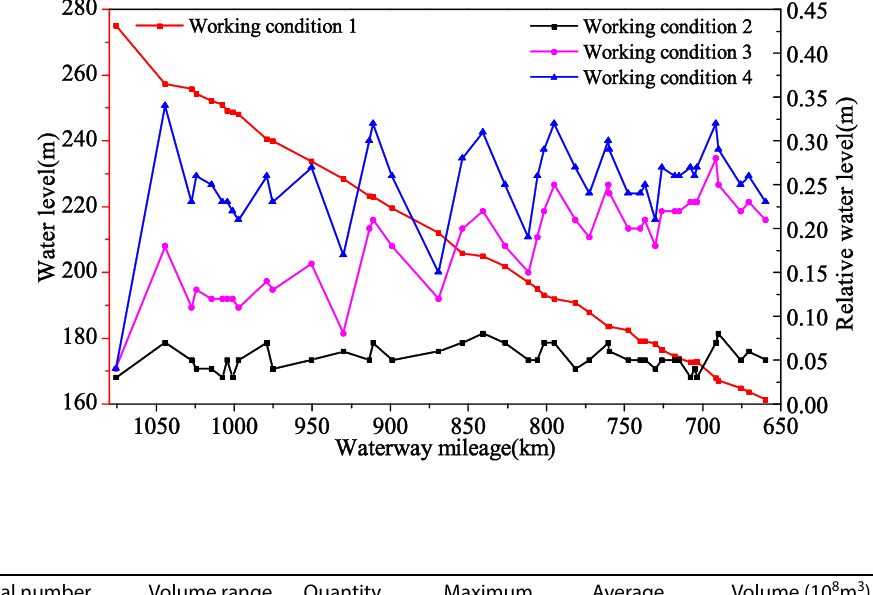
Table 5 Estimation of sand mining characteristic parameters along the Chongqing to Yibin river reach